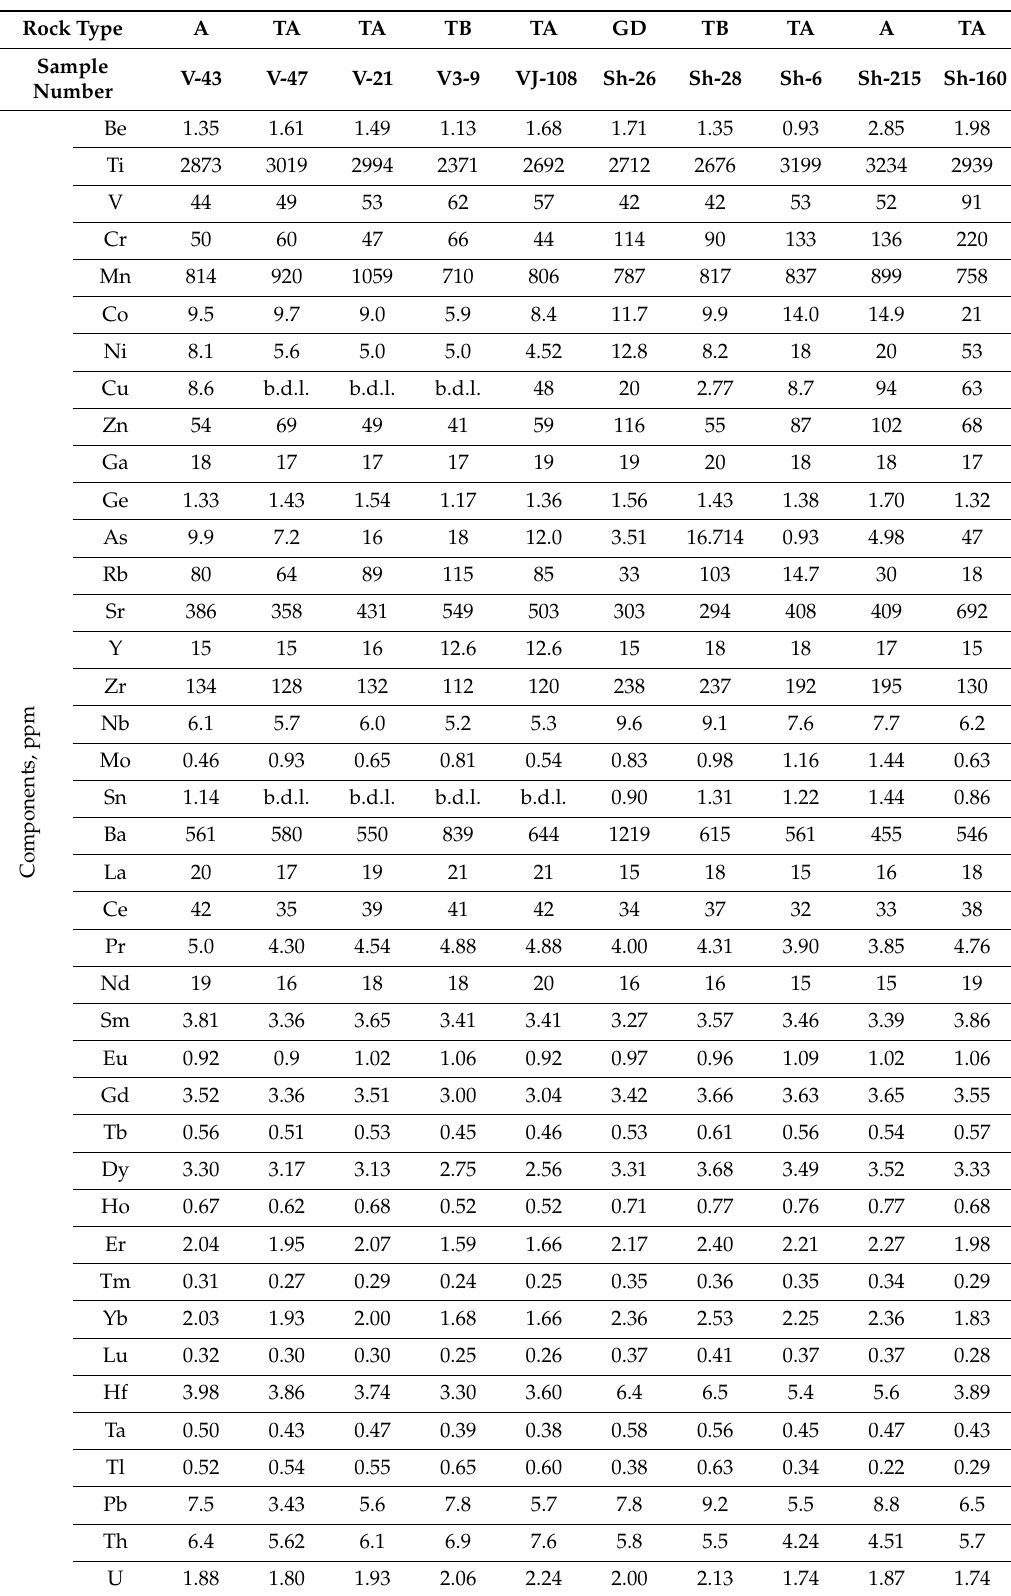
Table 3. Trace element compositions of the studied igneous rocks from the Vyun and Shumniy sites. Rock Type